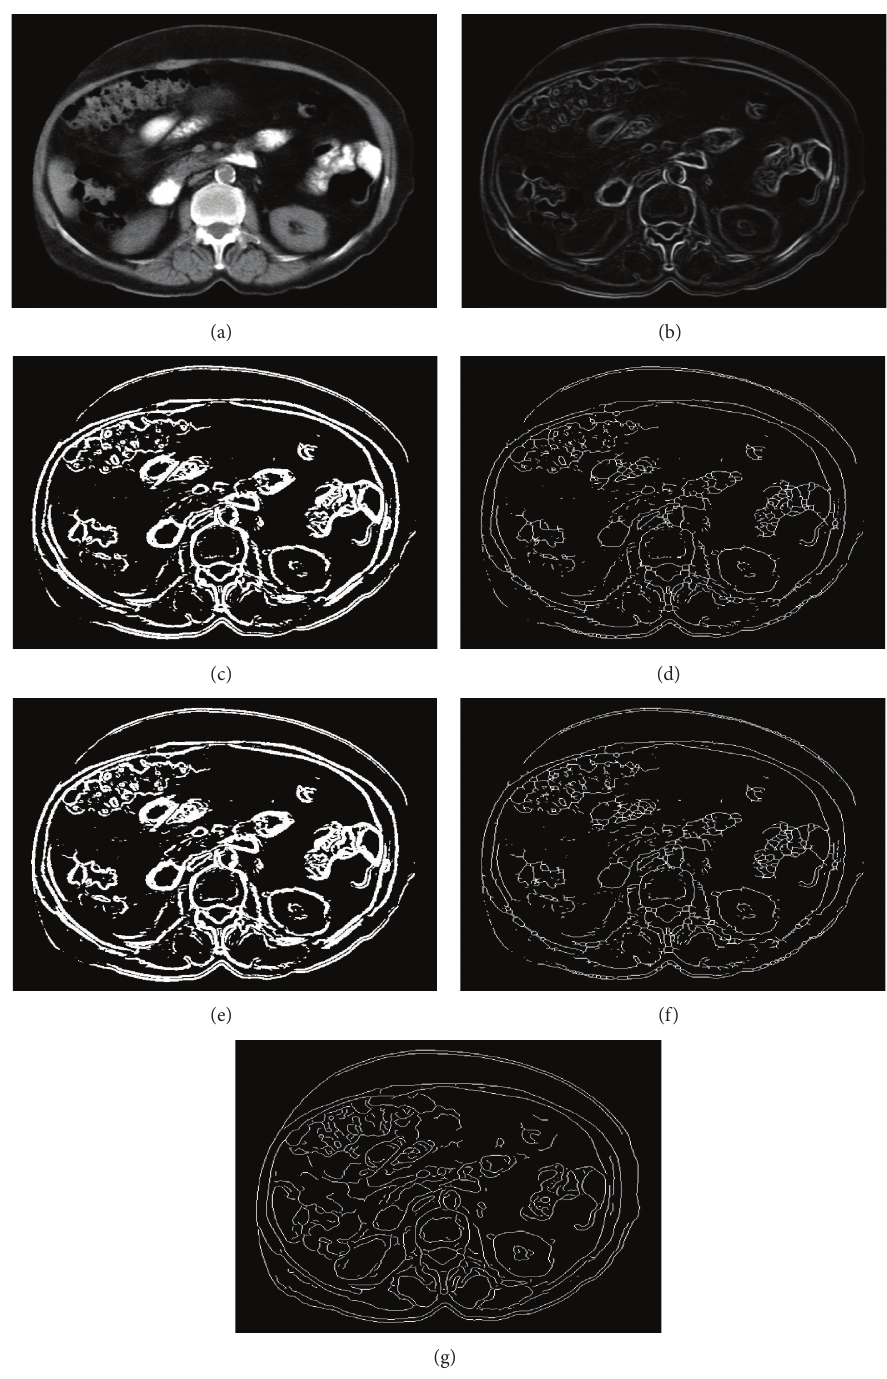
Figure 7: Edges of a CT scan abdominal image (𝜎 = 0.18 and 𝜔 = 0.0005) ; (a) original, (b) GWT, (c) 𝑘 -means, (d) skeleton of (c), (d) FCM, (e) skeleton of (d), and (g)